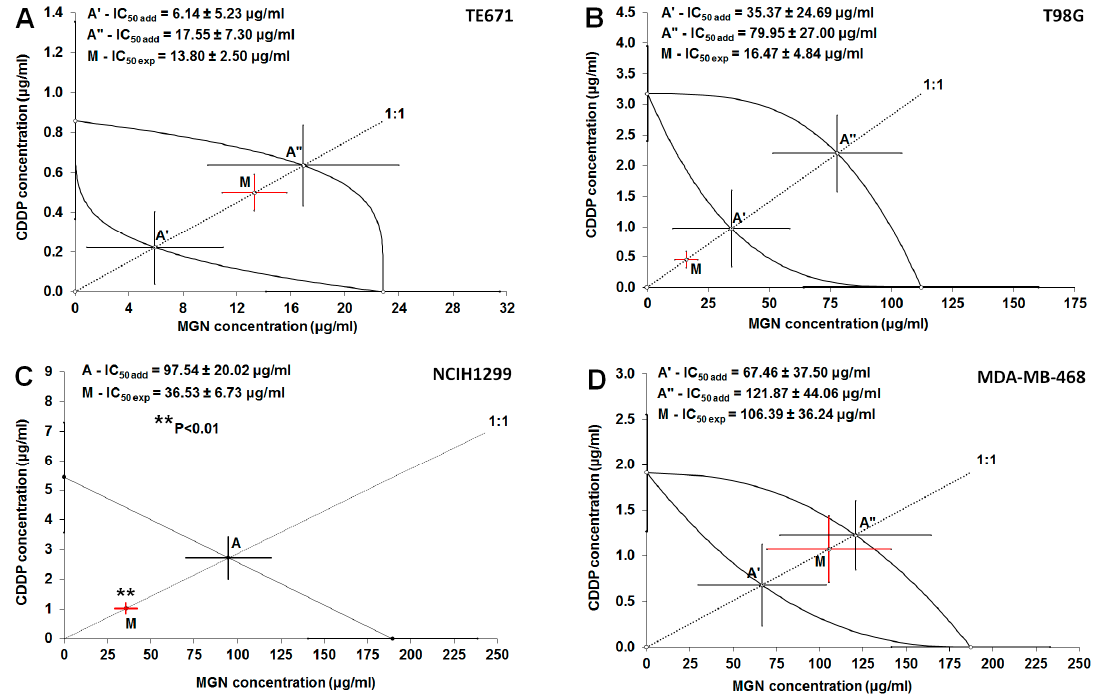
Figure 6. Isobolograms for additive and synergistic interactions between MGN and CDDP in four cancer cell lines. ( A ) Isobologram for the additive interaction of MGN with CDDP in the TE671 cancer cell line. ( B ) Isobologram for the additive interaction of MGN with CDDP in the T98G cancer cell line. ( C ) Isobologram for the synergistic interaction of MGN with CDDP in the NCIH1299 cancer cell line; ( D ) Isobologram for the additive interaction of MGN with CDDP in the MDA-MB-468 cancer cell line. The IC 50 ± S.E.M. for MGN and CDDP are plotted on the abscissa and ordinate of the Cartesian system of coordinates. The dotted line starting from the beginning of the Cartesian plot system illustrates the fixed drug concentration ratio of 1:1 for the mixture of two studied drugs (MGN and CDDP). The hyperbolic curves that connect the IC 50 values placed on X- and Y-axes illustrate the lower and upper lines of additivity for nonparallel concentration-e ff ects (a,b,d). For nonparallel concentration-e ff ect relationship lines of MGN and CDDP (a,b,d), the lower and upper isoboles of additivity form the additivity area between the curves connecting the IC 50 values for MGN and CDDP administered singly. Intersections of the dotted line for the fixed ratio of 1:1 with lower and upper lines of additivity illustrate, in approximation, the additivity points A’ and A”(a,b,d). The theoretically calculated IC 50 add values ( ± S.E.M.) are placed on the lower and upper isoboles of additivity as points A’ and A”, respectively. The experimentally derived IC 50 exp value ( ± S.E.M.) for the two-drug mixture of MGN and CDDP is placed as the point M, on the dotted line for the fixed ratio of 1:1. Since the point M is placed between the points A’ and A” within the area of additivity (a,d), the interaction between MGN and CDDP is additive in the TE671 and MDA-MB-468 cancer cell lines. Since the point M is placed close to the point A’ for the lower isobole of additivity (b), the interaction is additive with a tendency towards synergy in the T98G cancer cell line. For parallel concentration-e ff ect relationship lines of MGN and CDDP (c), the straight diagonal line of additivity connects the IC 50 values placed on X- and Y-axes for MGN and CDDP administered singly. Intersection of the dotted line for the fixed ratio of 1:1 with the line of additivity illustrates, in approximation, the point of additivity A (c). The theoretically calculated IC 50 add value ( ± S.E.M.) is placed on the line of additivity as the point A. The experimentally derived IC 50 exp value ( ± S.E.M.) for the two-drug mixture of MGN and CDDP is placed on the graph as the point M. Since the point M is placed significantly below the point A (c), the interaction between MGN and CDDP is supra-additive (synergistic) in the NCIH1299 cancer cell line. ** p < 0.01 vs. IC 50 add.